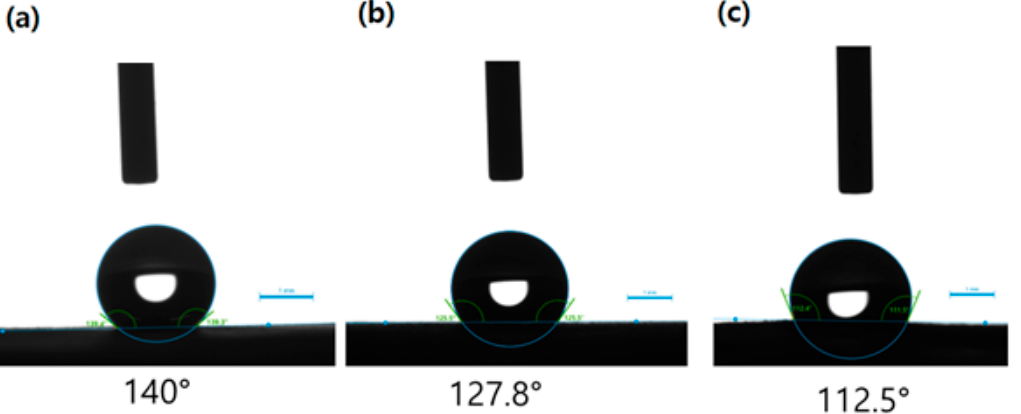
Figure 6. Contact angles of ( a ) 10 wt% TiO 2 -CA nanofibers, ( b ) 5 wt% TiO 2 -CA nanofibers, and ( c ) untreated CA nanofibers.